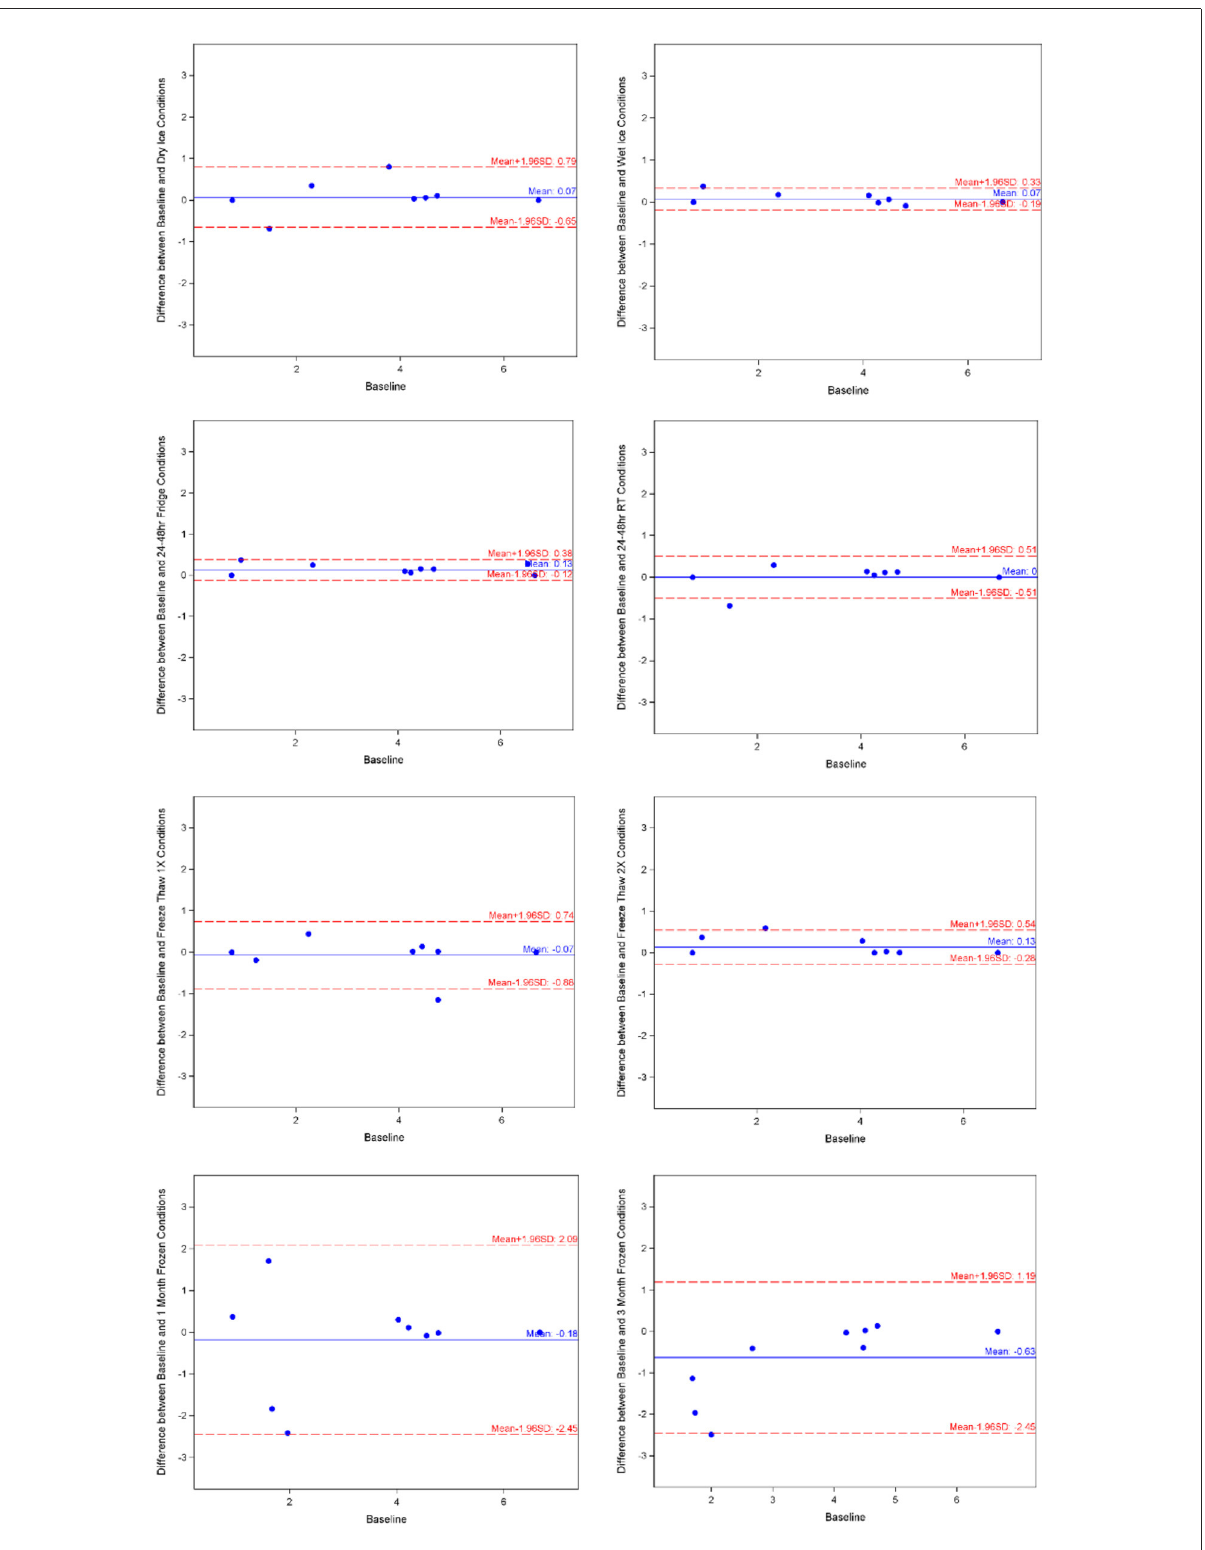
FIGURE3 Ceruloplasmin Bland-Altman charts by experimental condition. Image made with